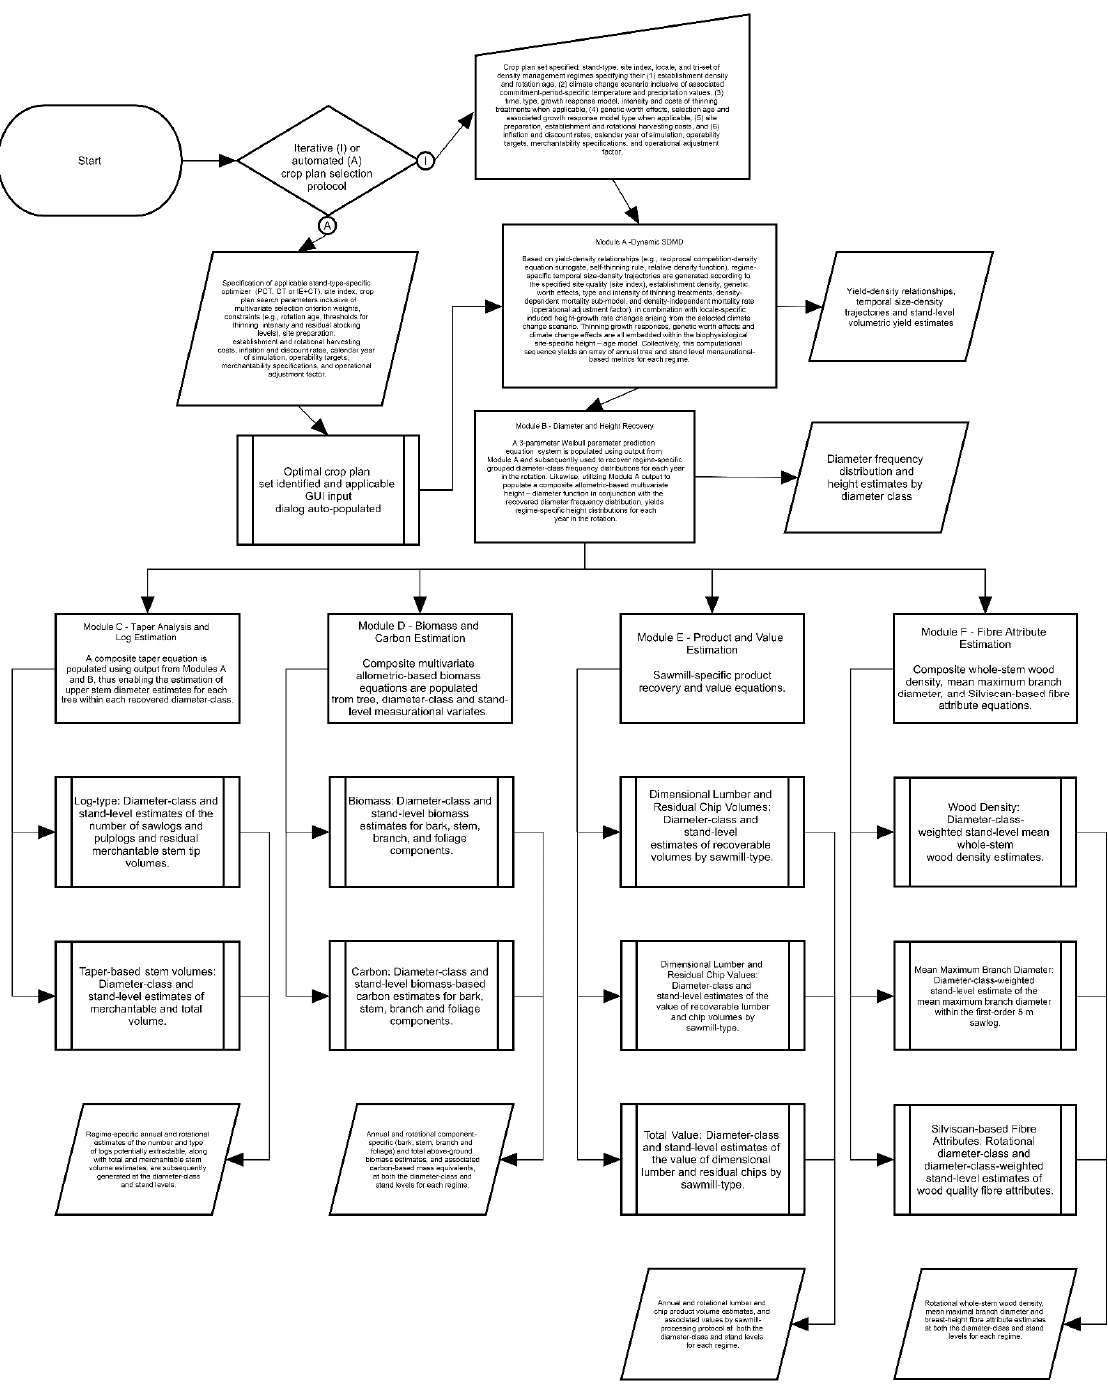
Figure 1. Schematic illustration of the CP DSS : flowchart of the computational sequence and hierarchical algorithmic structure inclusive of input requirements, decisional pathways and output produced.